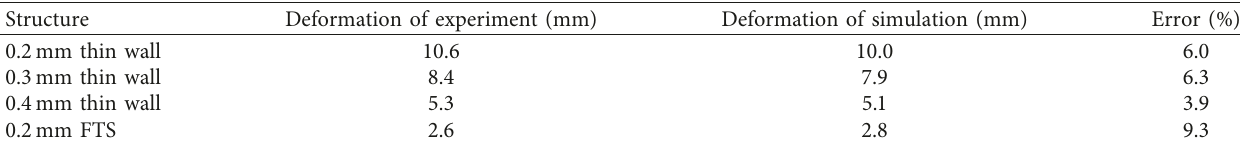
Figure 14: Deformation of simulation. (a) Thin wall with a thickness of 0.2 mm, (b) thin wall with a thickness of 0.3mm, (c) thin wall with a thickness of 0.4mm, and (d) FTS. Table 4: Deformation data.